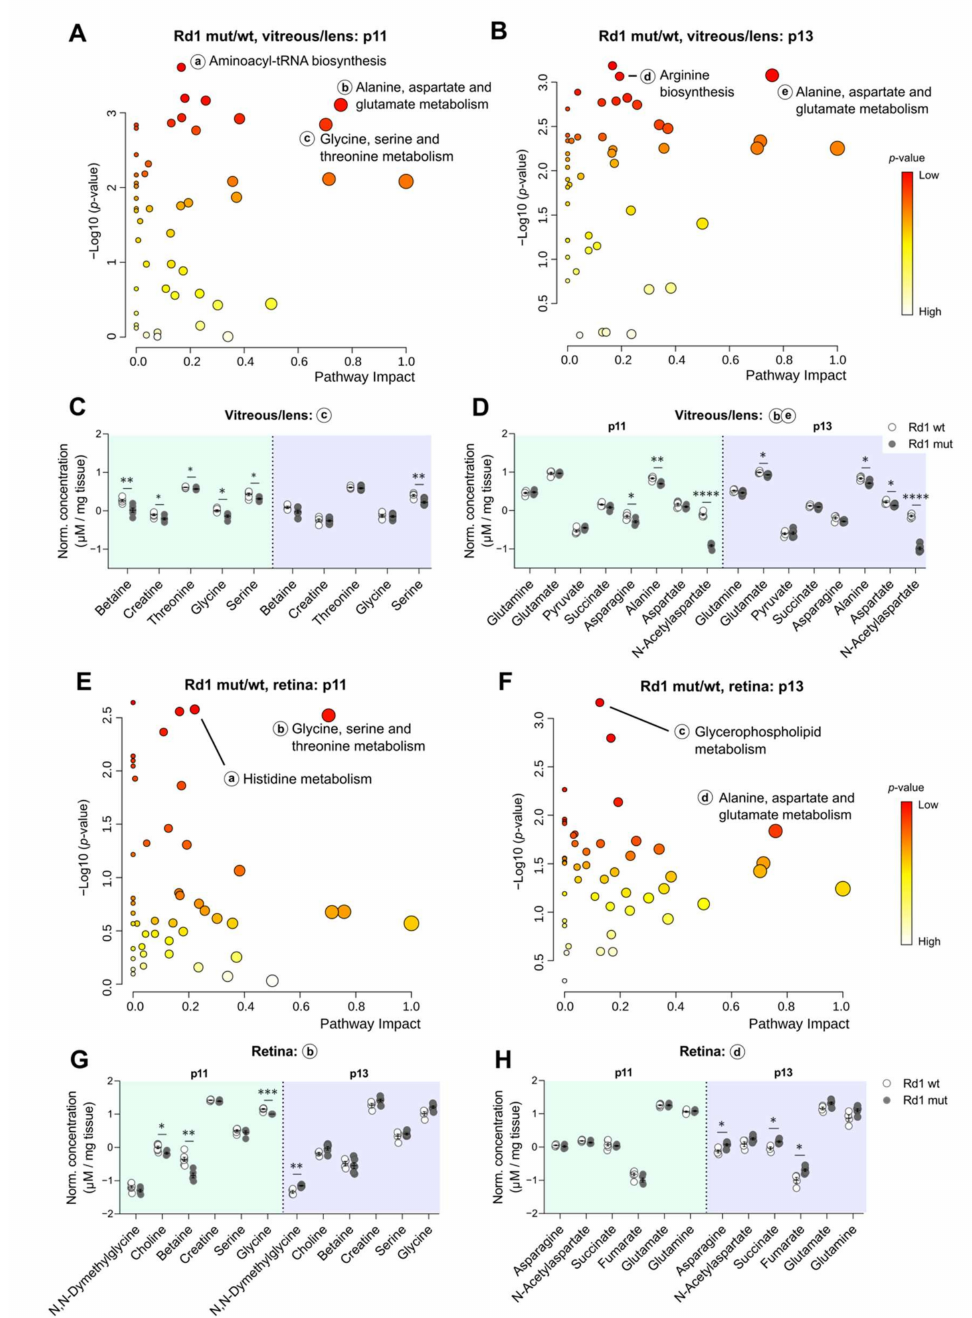
Figure 6. Different metabolic pathways are altered as a result of the degeneration in both eye compartments and at different time-points. ( A , B ) Pathway analysis of the metabolites enriched in the vitreous/lens at p11 ( A ) and p13 ( B ) in Rd1 mutant compared to wt mice. Small letters indicate prominent pathways at the specified time-points. ( C , D ) Concentration values of metabolites in the vitreous/lens involved in the pathways indicated by the small letter (as in subfigures ( A , B )), at p11 ( C ) and p13 ( D ). ( E , F ) Pathway analysis of the metabolites enriched in the retina at p11 ( E ) and p13 ( F ) in Rd1 mutant compared to wt mice. Small letters indicate prominent pathways at the specified time-points. ( G , H ) Concentration values of metabolites in the retina involved in the pathways indicated by the small letter (as in subfigures ( E , F )), at p11 ( G ) and p13 ( H ). Rd1 wt, vitreous/lens: n = 6 (p11), n = 5 (p13); retina: n = 7 (p11), n = 4 (p13). Rd1 mutant, vitreous/lens: n = 6 (p11), n = 7 (p13); retina: n = 5 (p11), n = 6 (p13). Multiple unpaired t test with Holm–Š í d á k correction for multiple comparisons. * p < 0.05, ** p < 0.01, *** p < 0.001, **** p <